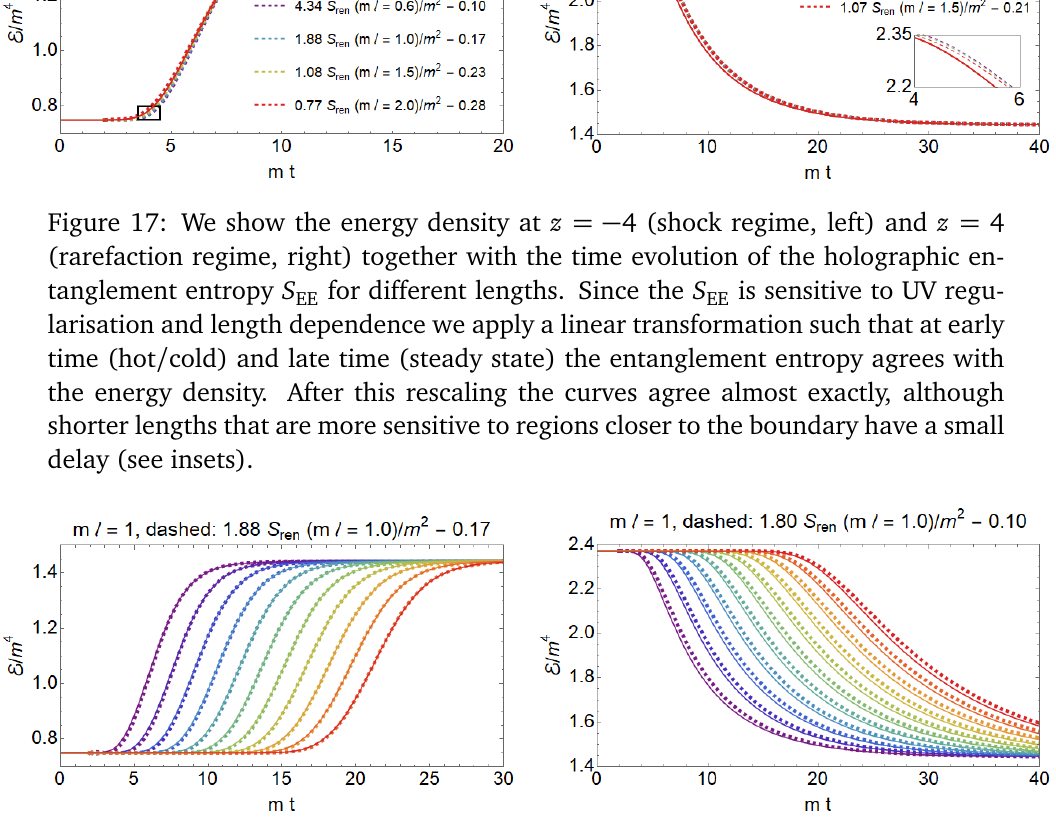
Figure 18: Similarly to Figure 17, for (cid:96) = 1 we now show the energy density (solid) as well as the rescaled HEE (dashed, the rescaling parameters are the same as in Figure 17 for (cid:96) = 1) for different positions of the entangling region, varying from − 4 till − 14 (left, shock region) and from 4 till 14 (right, rarefaction region). Note that the rescaling is the same for all curves, which reaffirms that the evolution of the HEE is almost entirely determined by the evolution of the energy